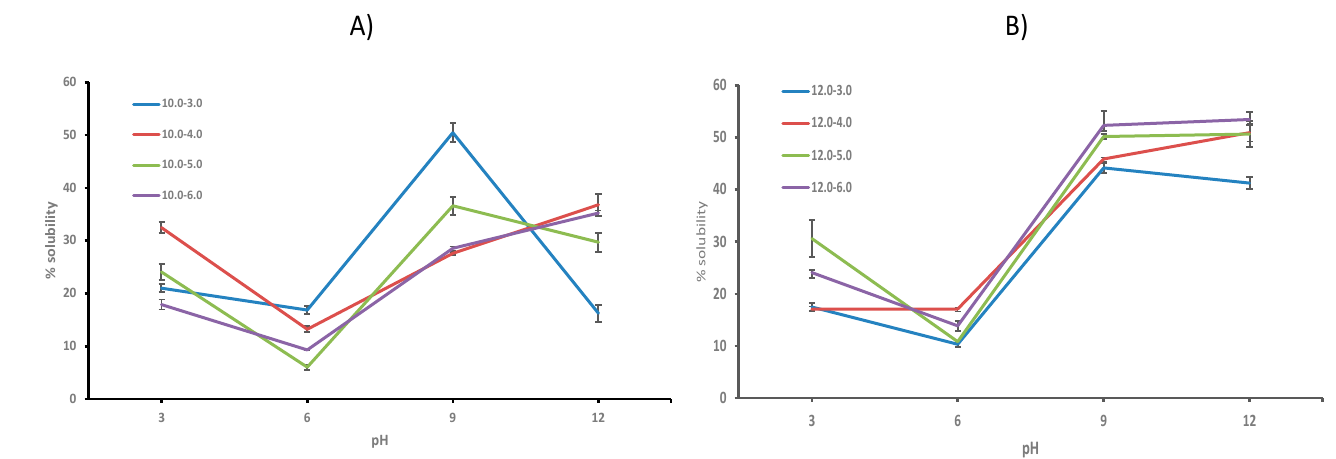
Figure 1. Protein solubility of cricket protein (CPC) at pHs 3.0, 6.0, 9.0, and 12.0. Protein solubility is affected by the extraction and precipitation pH used in the process of obtaining proteins. Insect proteins have their pI isoelectric point around pH 4.0. The pI of silkworm ( Bombyx mori ) and spider ( Nephila edulis ) proteins has been reported at pH values of 4.37–5.05 and 6.47, respectively [37]. In this study we have used isoelectric points between pH 3.0 and pH 6.0.